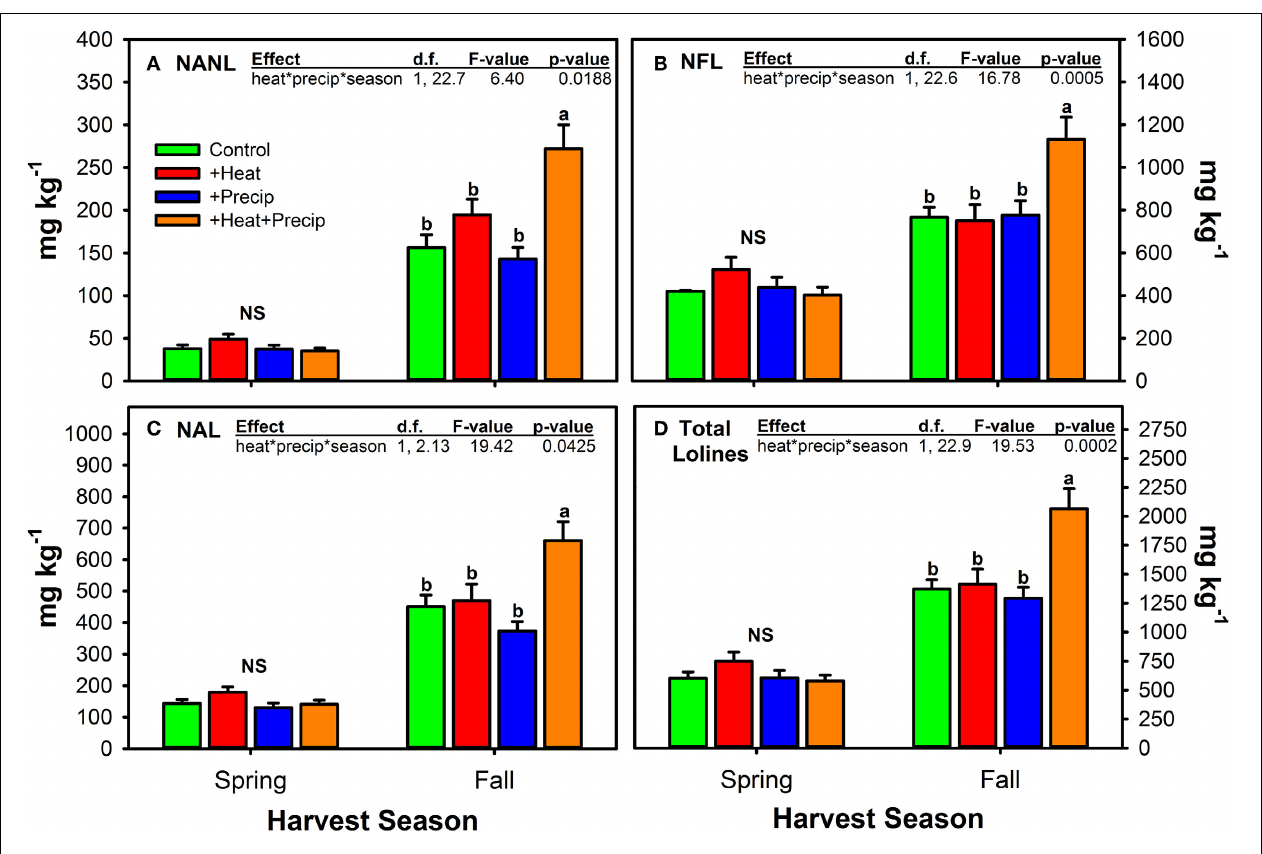
FIGURE 6 | Concentrations of N -acetyl norloline—NANL (A), N -formyl loline—NFL (B), N -acetyl loline—NAL (C), and the sum of these three loline alkaloids (D) measured in endophyte-infected tall fescue tillers from each of the four climate treatments averaged ( ± SE) by season of harvest (Spring or Fall) and across years of the study. The highest order